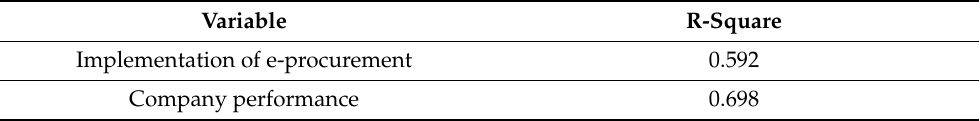
Table 8. Results of R-square value.